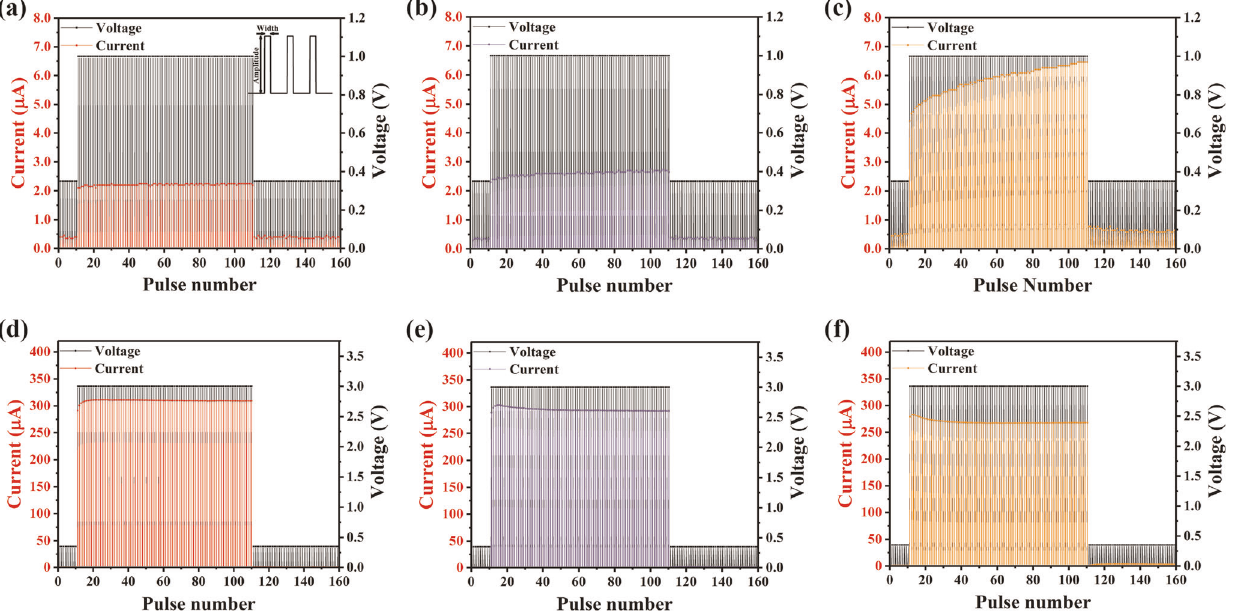
Fig. 4 Response of the post-synaptic current with various stimuli. Plasticity characteristics of the arti fi cial synapse stimulated by 100 consecutive pulses with an amplitude of 1 V and pulse widths of 5 ms, 10 ms, and 30 ms in a – c , respectively. Enhancement in synaptic potentiation was observed with the increasing pulse width of the stimuli, which corresponds to the increase of pain-signal with the increase of external stimuli. d A saturation and even inhibition in the synaptic plasticity depending on the pulse width were obtained when the stimulation voltage increased to 3